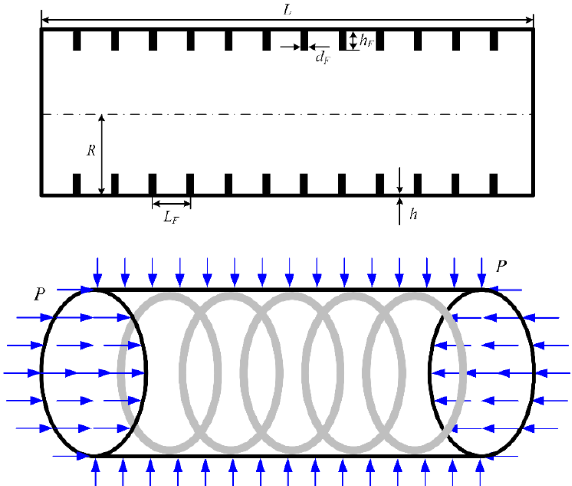
Figure 1. Schematic of ring-stiffened porous GPLRC cylindrical shell under hydrostatic pressure.